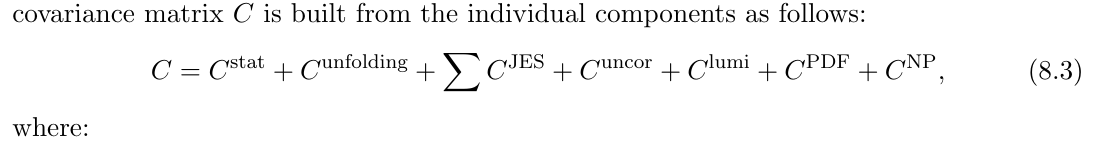
Figure 9 . The ratios of the inclusive jet production cross sections at as a function of jet p T for the absolute rapidity ranges 1 : 0 < j y j < 1 : 5 and 1 : 5 < j y j < 2 :